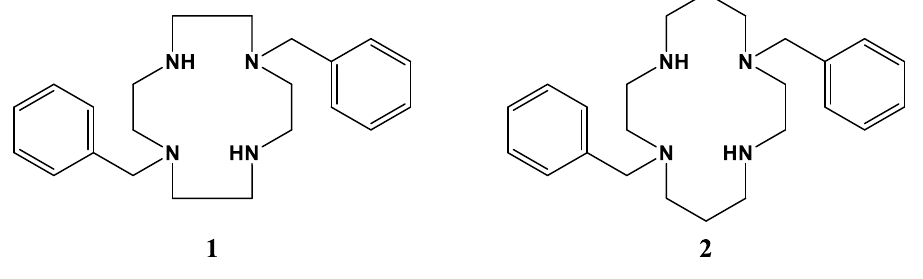
Figure 2. 1,7-dibenzylcyclen ( 1 ) and 1,8-dibenzylcyclam ( 2 ).